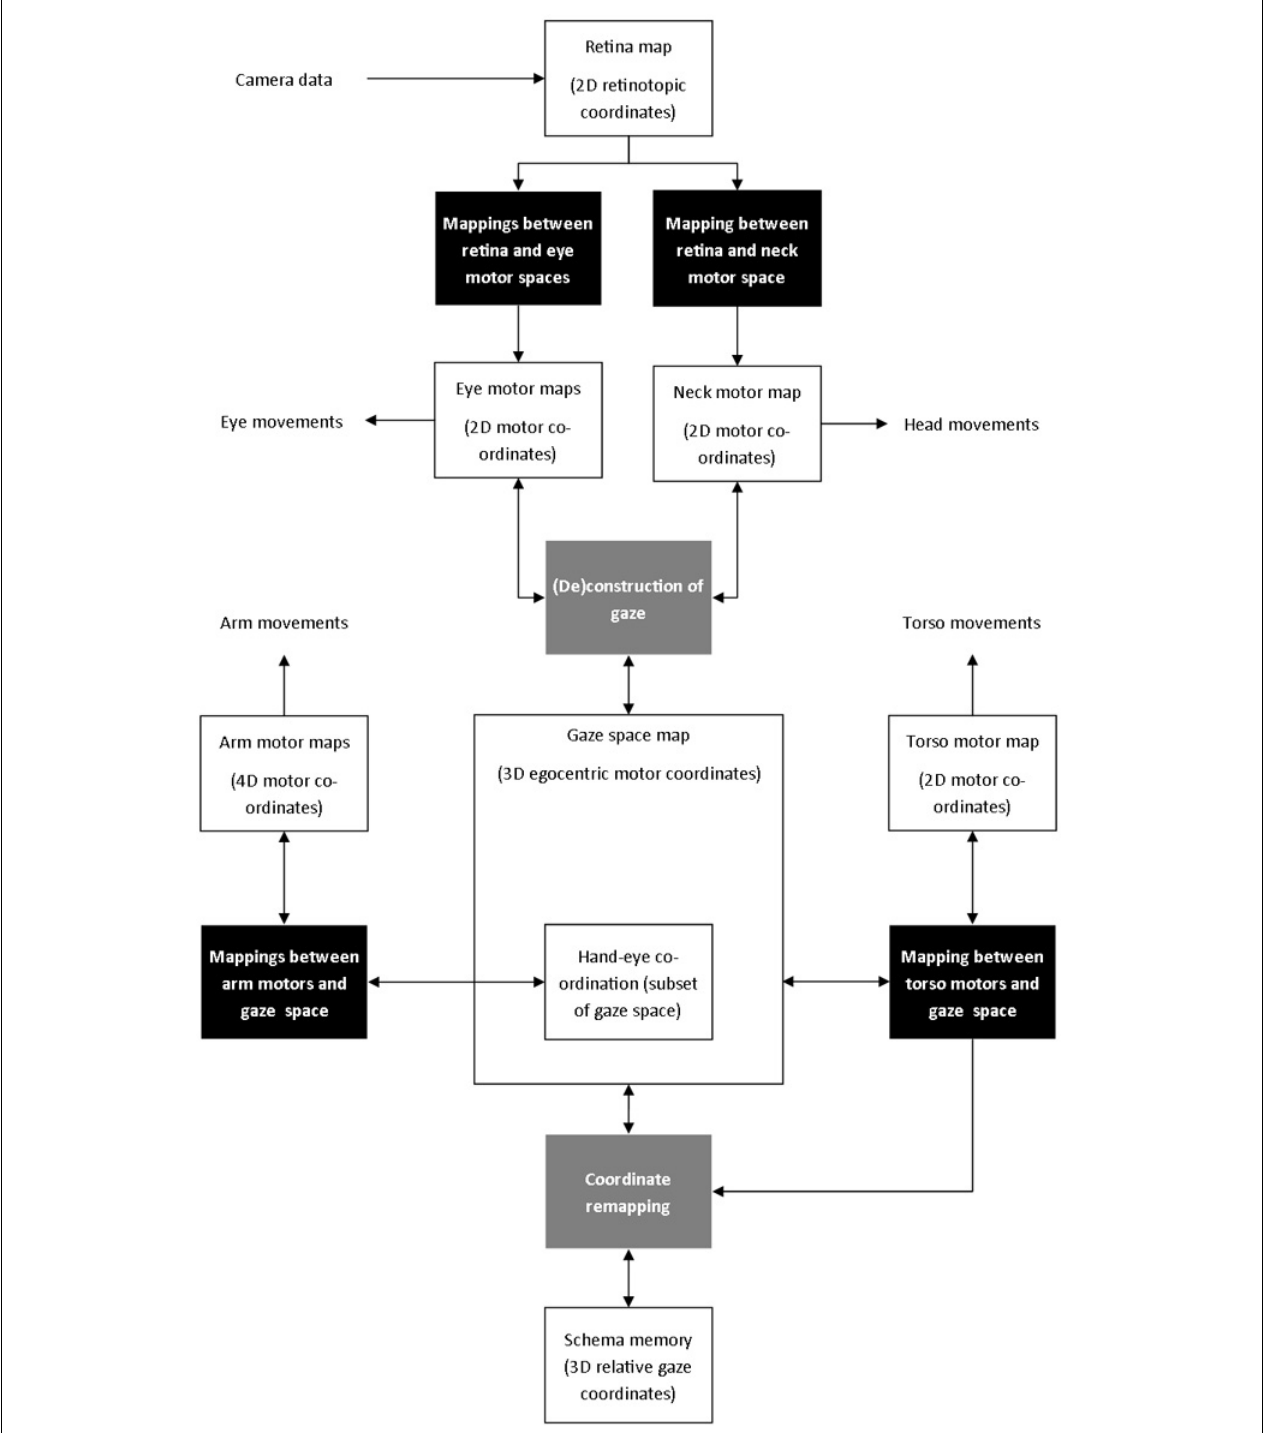
FIGURE 4 | System